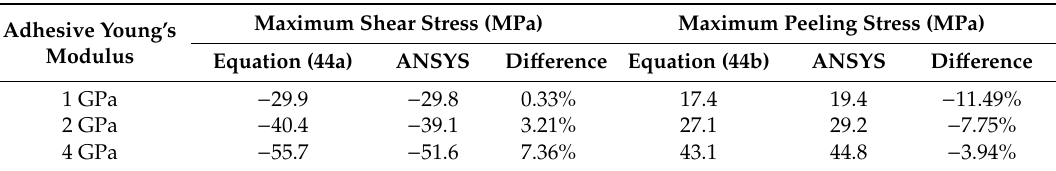
Figure 9. Shear stress distribution in the adhesive with three different Young’s moduli of the adhesive. Table 4. Comparison of maximum interfacial stresses with di ff erent adhesive Young’s modulus obtained by Equation (44) and